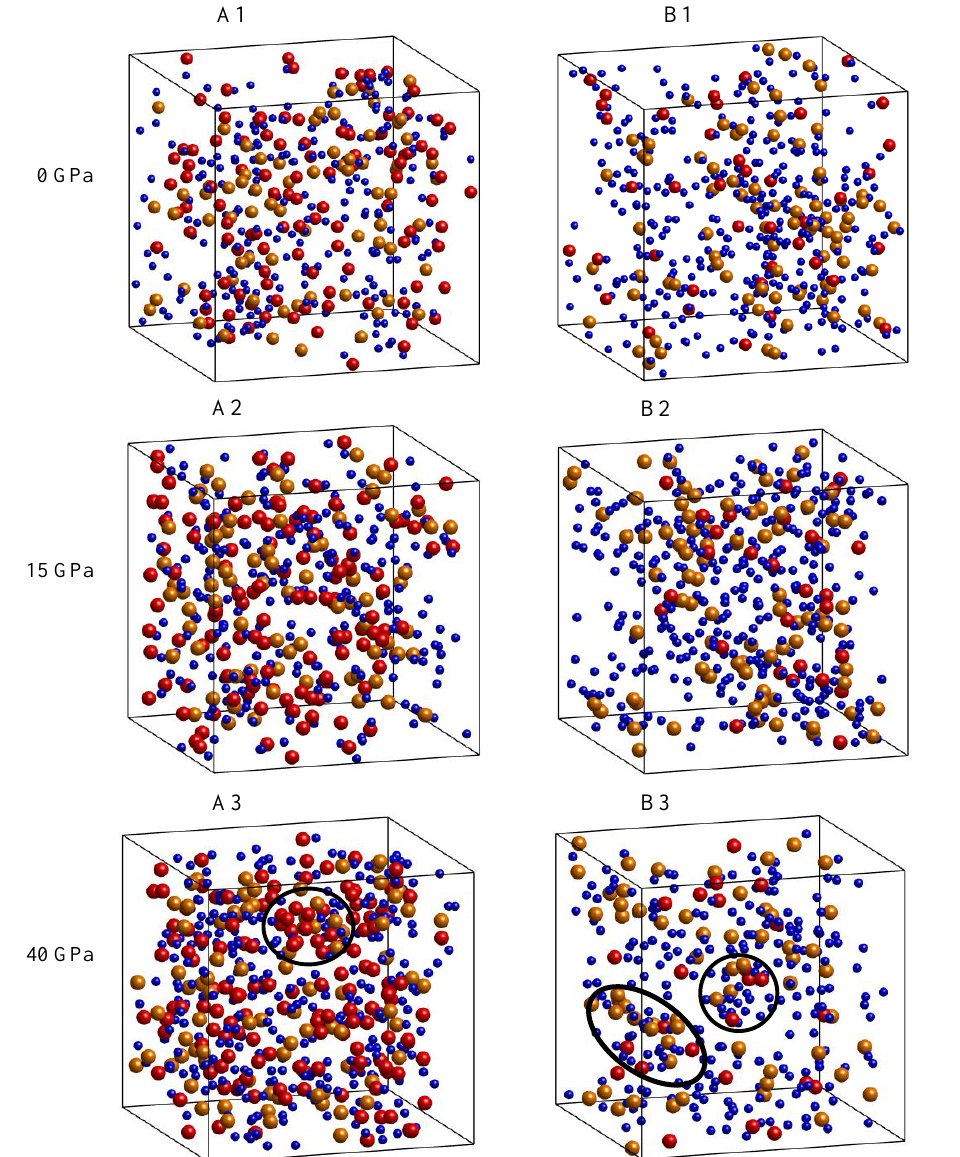
Figure 11. Snapshot of the positions of the slowest (A1, A2, A3) and fastest (B1, B2, B3) atoms for the AS2 models at 0, 15 and 40 GPa. Here, the red, blue and dark-yellow spheres represent the Si, O and Al atoms, respectively. The black-solid circles denote the clustering of the fastest and slowest